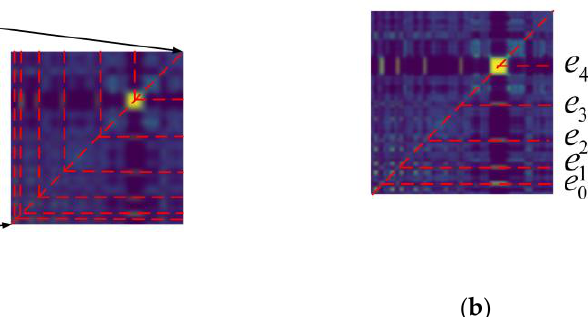
Figure 4. Electromagnetic feature scale space: ( a ) MTF scale space; ( b ) electromagnetic feature mapping.